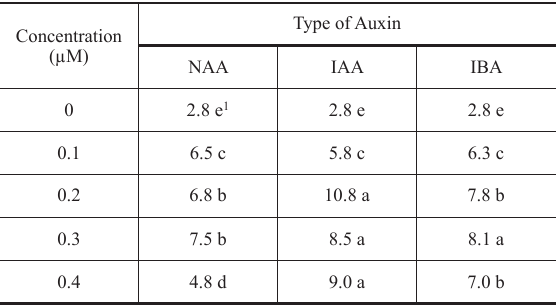
Average root numbers in elongated shoot of Verbena litoralis as affected by NAA, IAA and IBA, 45 d after in vitro culture.